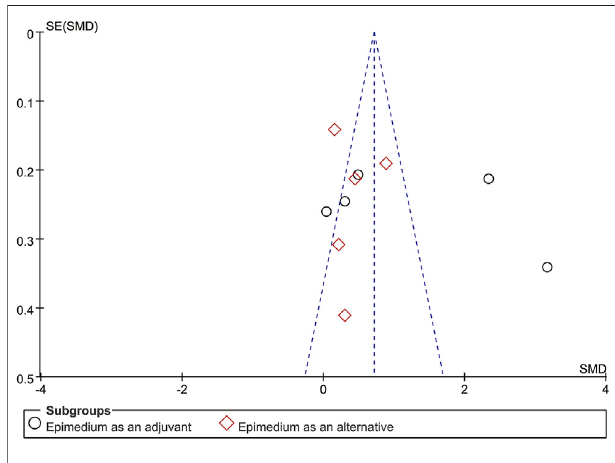
FIGURE 9 | Funnel plot of outcome of BMD.